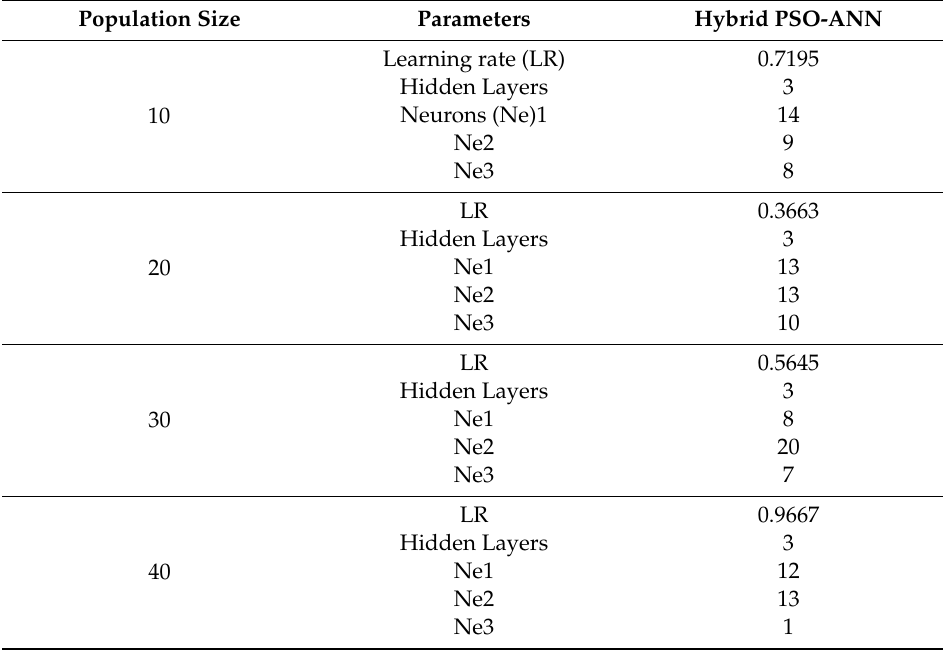
Table 1. Optimum value of optimized parameters in hybrid particle swarm optimization and artificial neural network (PSO-ANN) at di ff erent population sizes.